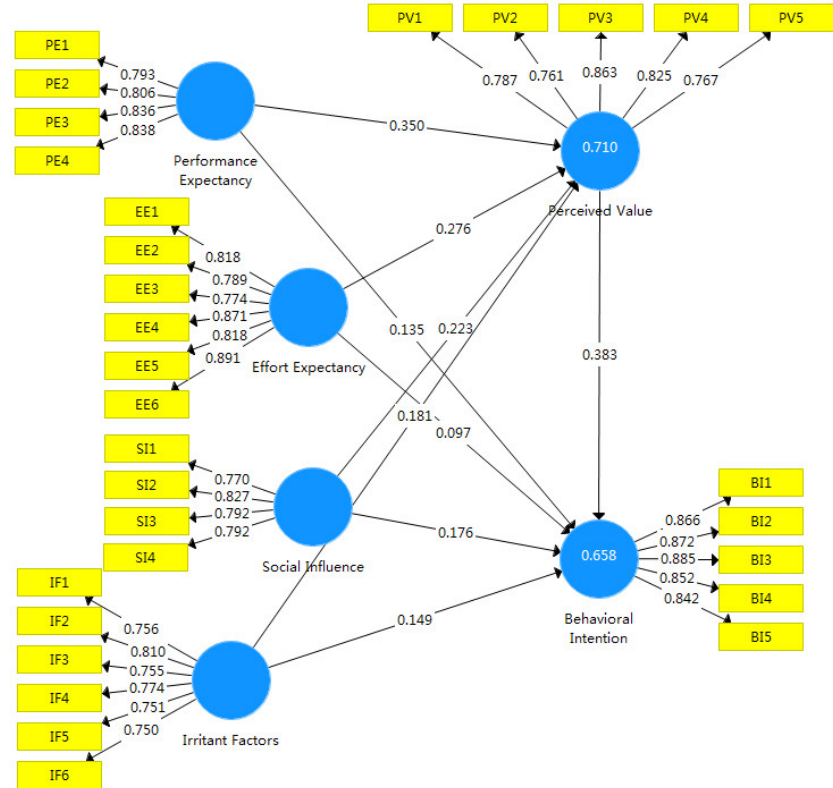
Figure 2. Original UTAUT model. Figure 3. Extended UTAUT